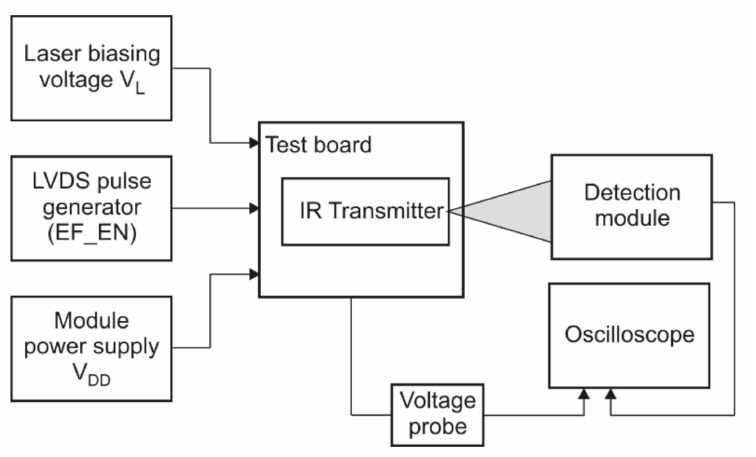
Figure 5. View of the testing setup and lasing device placed on the test board irradiating detection